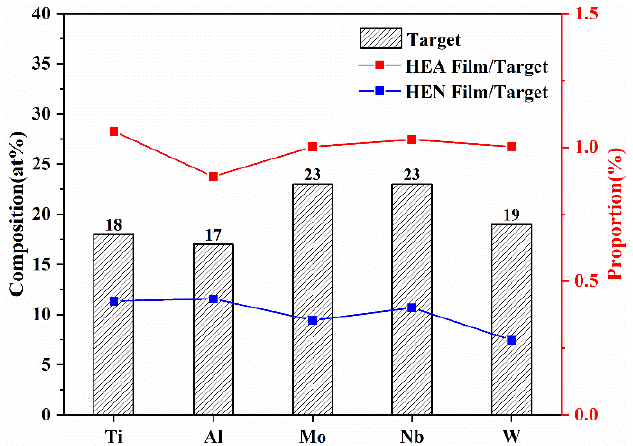
Figure 1. Chemical composition of the target and the composition ratio of different metallic elements in HEA and HEN films compared with that in the target.